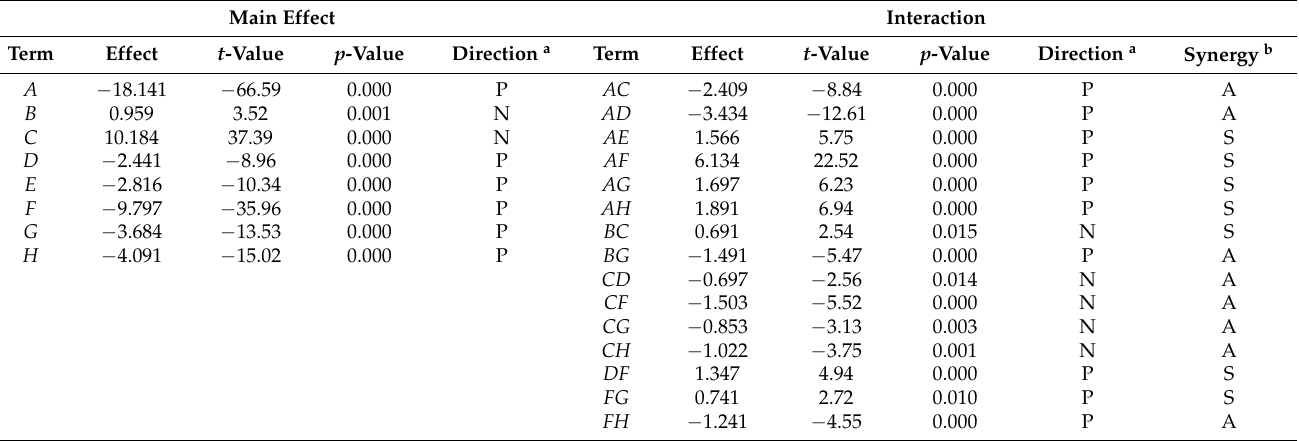
Table A2. Thesignificant maineffectsandinteractions ofthepressure difference atelevatordoor(1st floor).